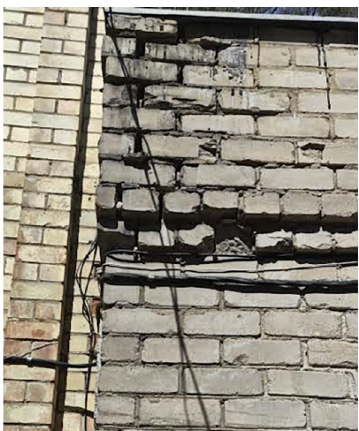
Figure 3. Developed algorithm for the assessment of